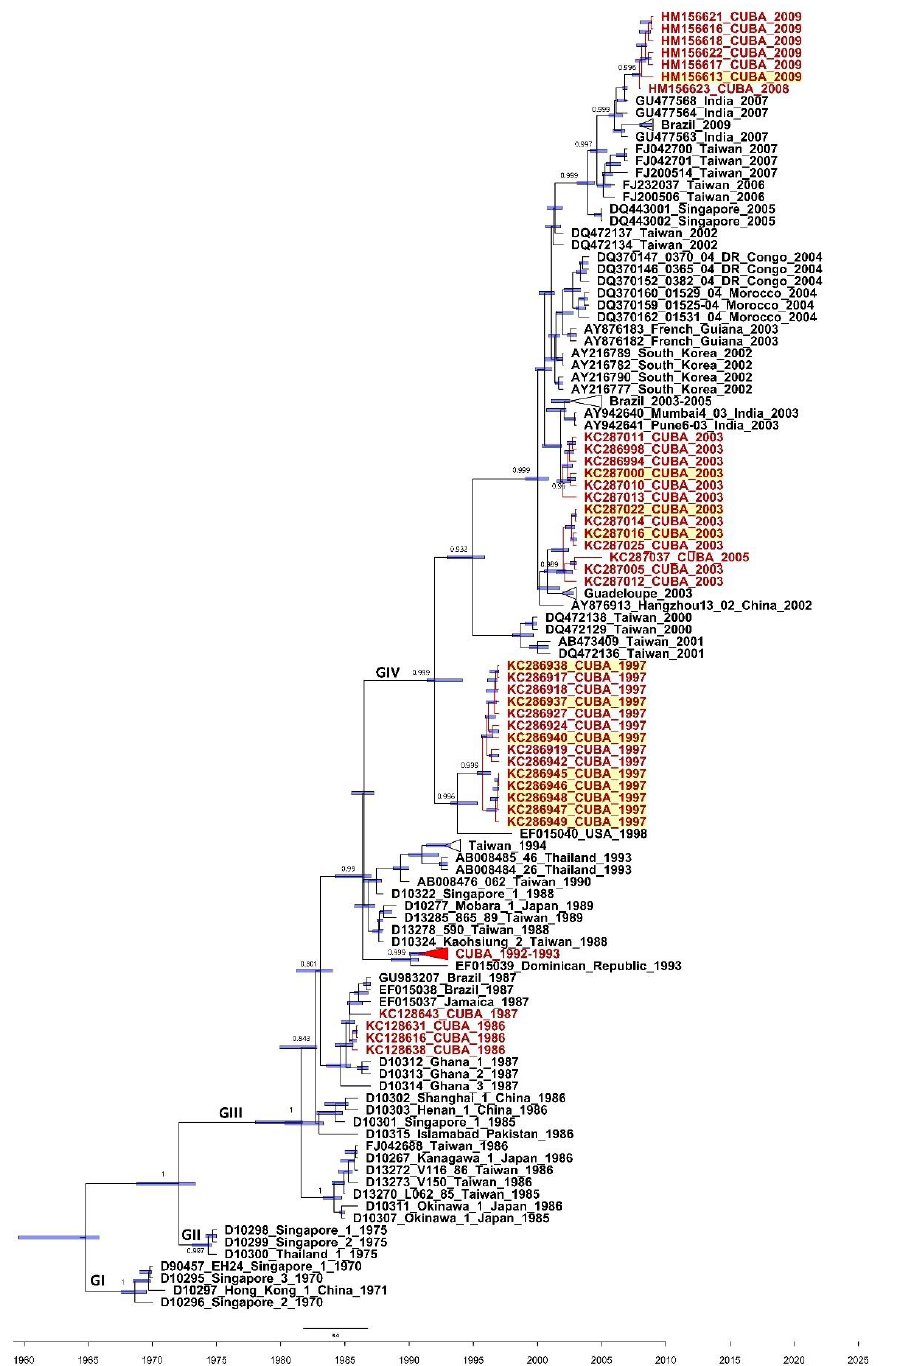
Figure 1. Maximum clade credibility (MCC) phylogeny of the 3C (507 nucleotides) coding region of the 54 Cuban (in red) and 83 worldwide CVA24v strains constructed by Bayesian method with the Bayesian Evolutionary Analysis Sampling Tree (BEAST) v1.8.4 program. Bars at nodes indicate with a 95% highest posterior density (HPD) the time of the most recent common ancestor (TMRCA). Support values with a posterior probability >0.700 are indicated at the nodes. Branches forming genotypes GI-GIV are shown. The sequences are indicated by the GenBank accession number, strain name, country, and year of isolation. The sequences obtained from feces isolates of acute hemorrhagic conjunctivitis (AHC) cases are highlighted in yellow.